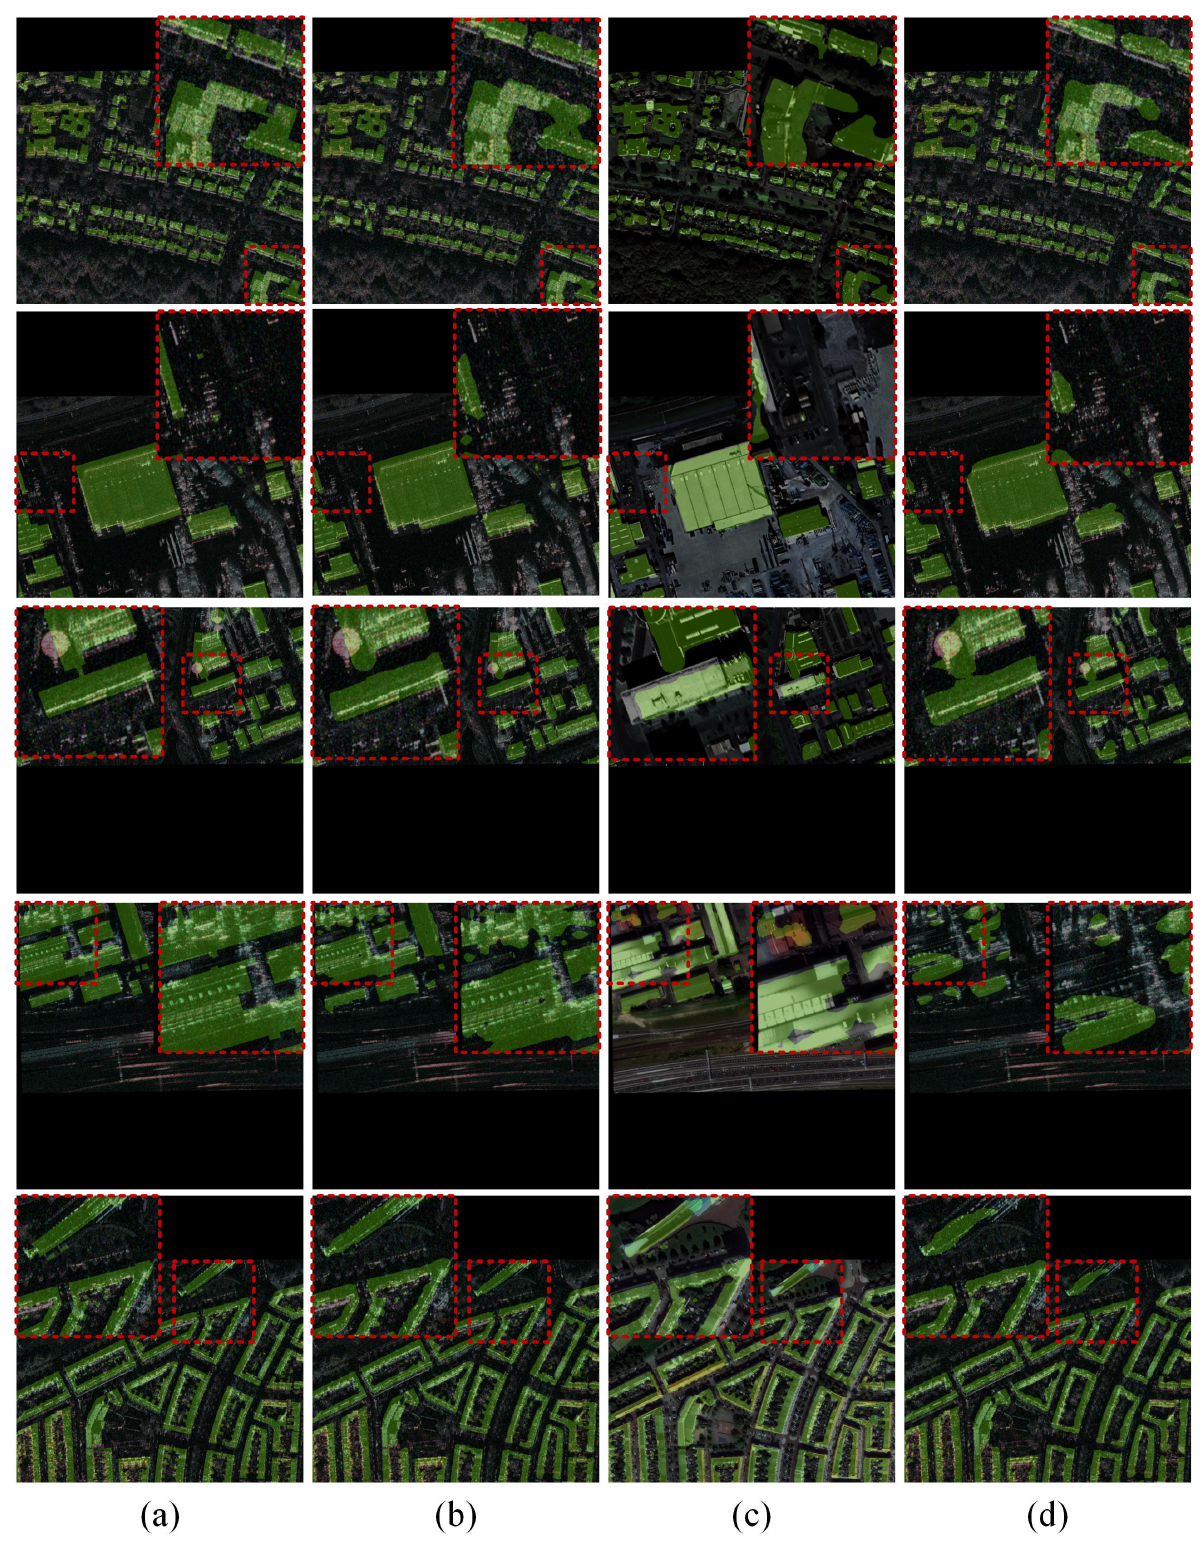
Figure 6. Results comparison of multi-source semantic segmentation, ( a ) ground truth, ( b ) MsIFT, ( c ) OPT and ( d ) SAR. Different rows represent the results in different scenarios. The red dotted rectangle areas are enlarged to show the results more